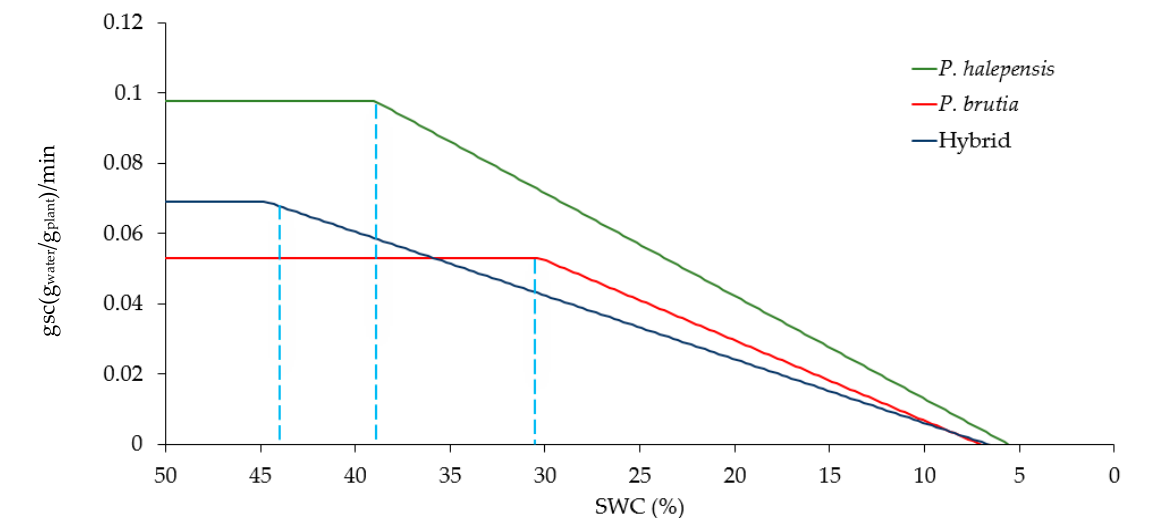
Figure 3. Midday maximum conductance of the whole canopy (g sc ) as a function of soil water content (SWC) in P. halepensis (green), P. brutia (red), and their hybrids (blue). Light blue dashed lines indicate physiological critical stress points ( θ ).